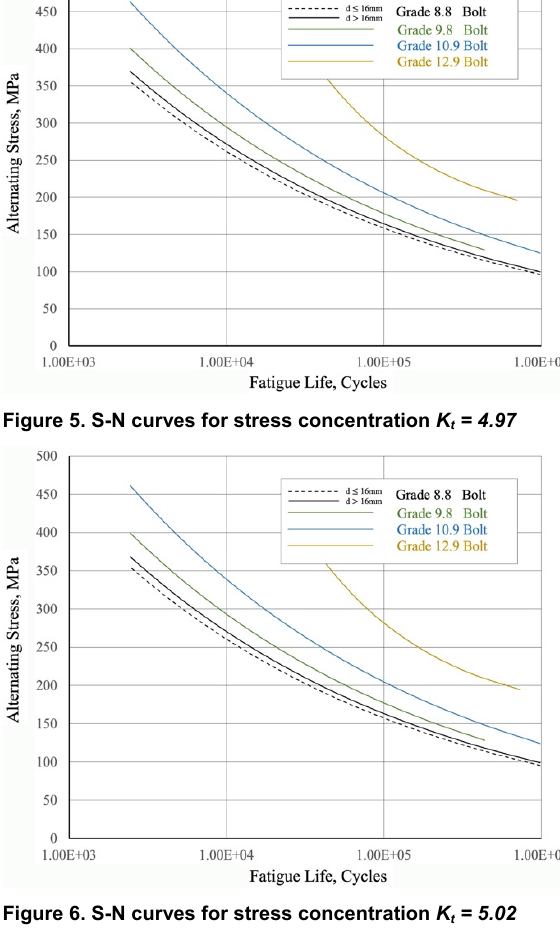
Figure 6. S-N curves for stress concentration K t =